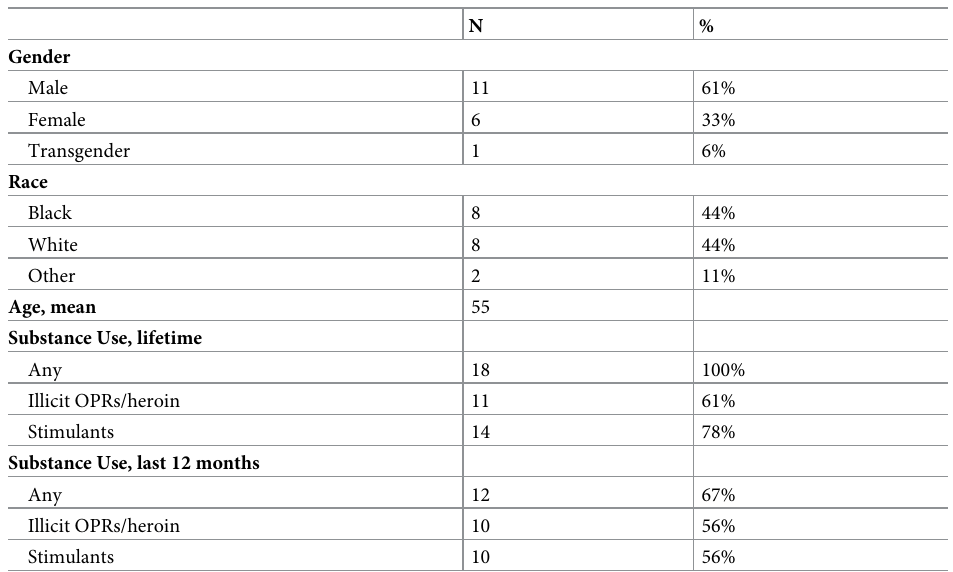
Table 1. Demographics and substance use (N =